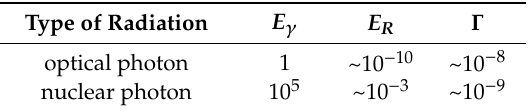
Figure 2. The resonant absorption is not possible if the recoil energy E R exceeds the linewidth Γ because, as shown in the figure, the emission and absorption lines do not overlap, not even partially. Reproduced from [4], with permission from Springer Nature, 2011. Table 1. Orders of magnitude of energies (in eV) of optical and nuclear photons and of corresponding recoil energies and linewidths.